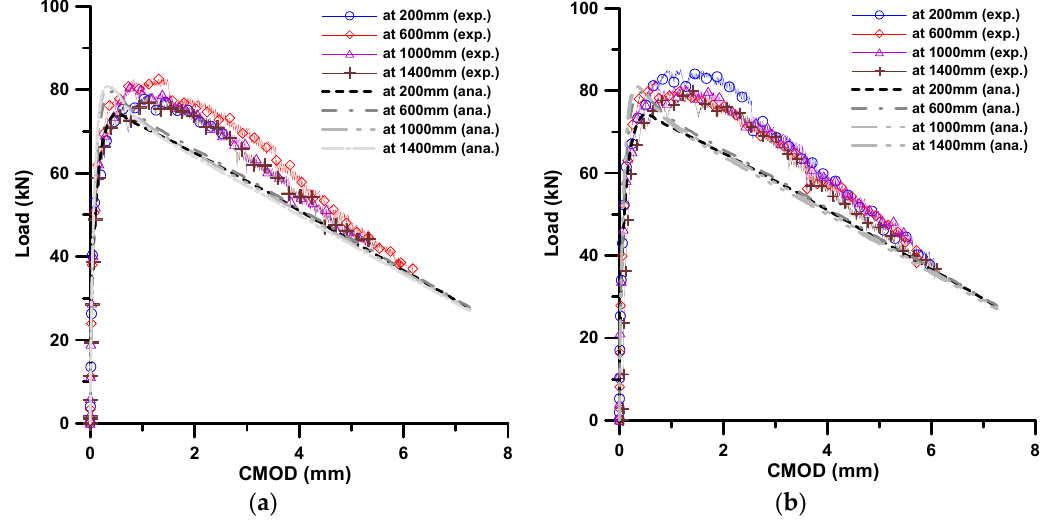
Figure 11. Comparison of flexural behaviors obtained from analysis and experiment; ( a ) from beam 1; and ( b ) from beam 2.